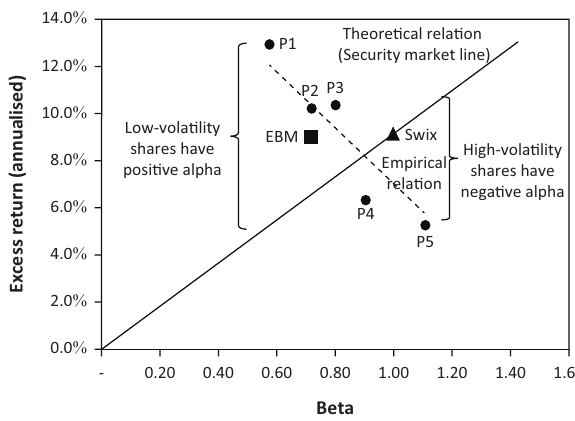
FIGURE 4: Volatility sorted portfolios and the security market line.